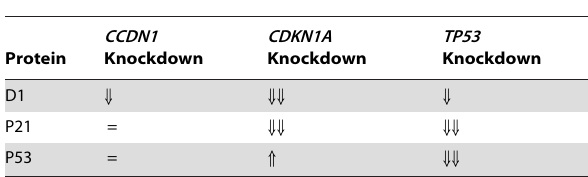
Figure 4. p21 is required for cyclin D1 stable expression post-p14ARF induction and cell inhibition. siRNA knockdown of CDKN1A , TP53 and CCND1 in MCF-7 p14ARF cells. For siRNA knockdown (KD) experiments, cells were seeded at 2.0 6 10 5 cells for 18h. Cells were transfected with siRNA complexes, CCND1 (cyclin D1), TP53 (p53), and CDKN1A ( p21 ) , and negative control siRNA. No treatment and mock transfection were included for comparative analysis. BLOCK-iT TM Fluorescent Oligo was co-transfected as an RNA transfection control. Twenty-four hours following transfection, cells were stimulated with or without IPTG (5mM) for a further 24h and then protein was extracted for Western blot analysis. A. Representative Western blots of relative p53, cyclin D1 and p21 protein expression. B. Protein expression of p53, cyclin D1, and p21, was measured for siRNA transfection using Kodak IM software and expressed as arbitrary units (AU). C. Comparative qRT-PCR analysis of CDKN1A, post - CCDN1 , - TP53 and – CDKNA1 siRNA knockdown. Experiments were performed in technical triplicate on three separate occasions (*P . 0.001, N=9). D. Representative live